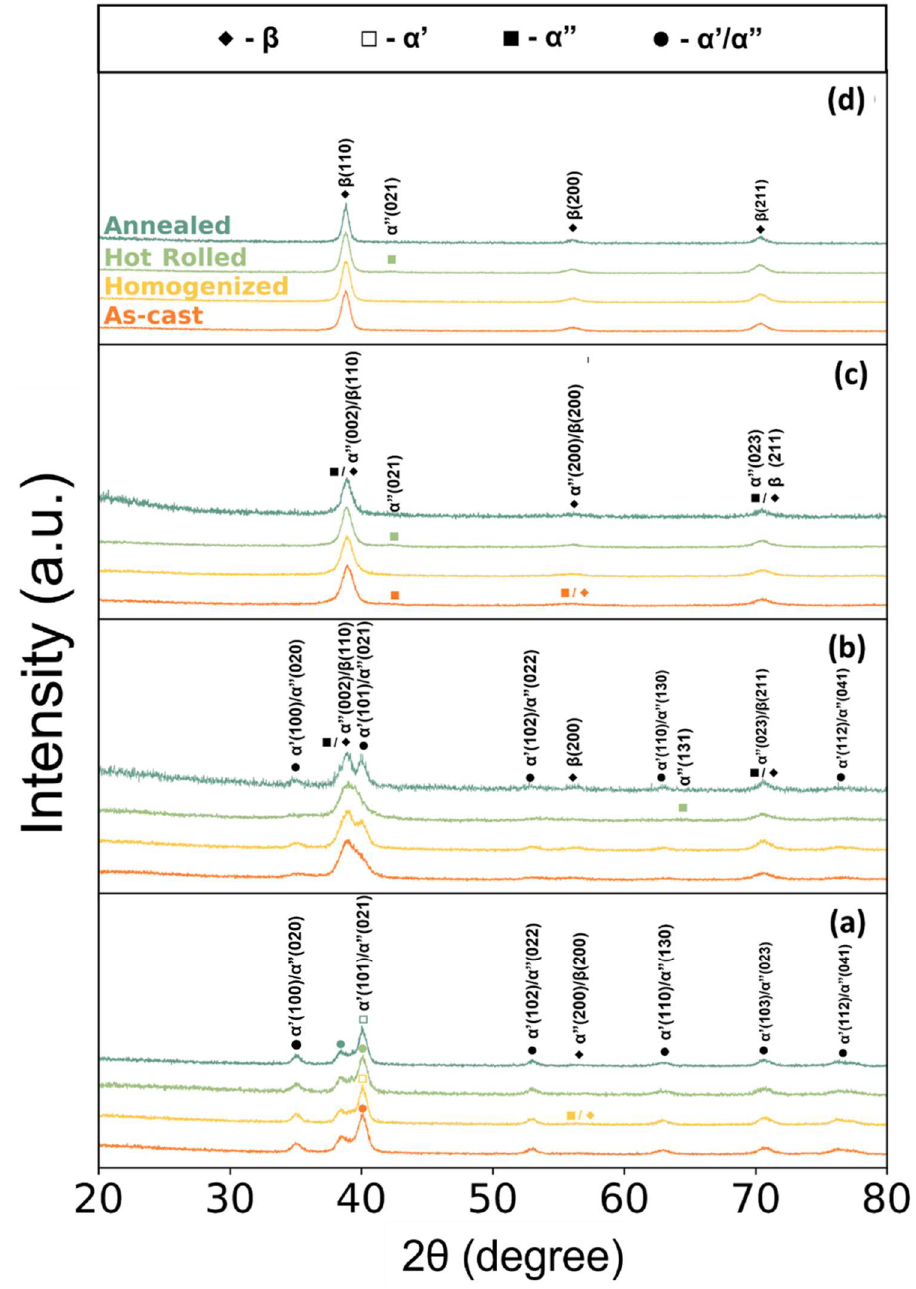
Figure 1. XRD diffractograms of the Ti-5Mo ( a ), Ti-10Nb-5Mo ( b ), Ti-20Nb-5Mo ( c ), and Ti-30Nb-5Mo ( d ) samples after thermomechanical processing.